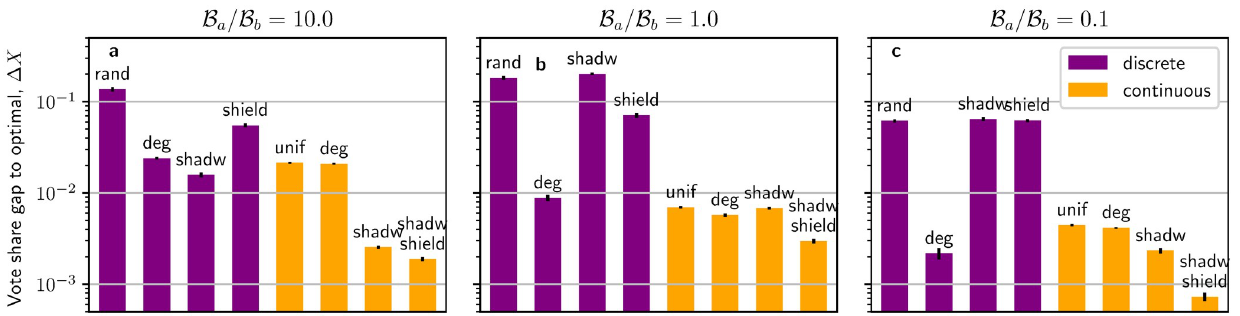
Fig 6. Comparison of various heuristics to optimal allocations. Bars represent the gap in vote share Δ X of the heuristics with respect to optimal numerical allocations for three different budget scenarios (as indicated on the top of the panels). Each bar represents one of the following heuristics: random ( rand ), degree-based ( deg ), shadowing-based ( shadw ), shielding-based ( shield ), uniform targeting ( unif ), combination of shadowing and shielding ( shadw shield ). The passive controller targets K = 16 nodes in the network in a discrete fashion. Error bars represent standard errors for 15 instances of the experiments and the total budget of both controllers sums up to B þ B ¼ N h d i = 30 . a b